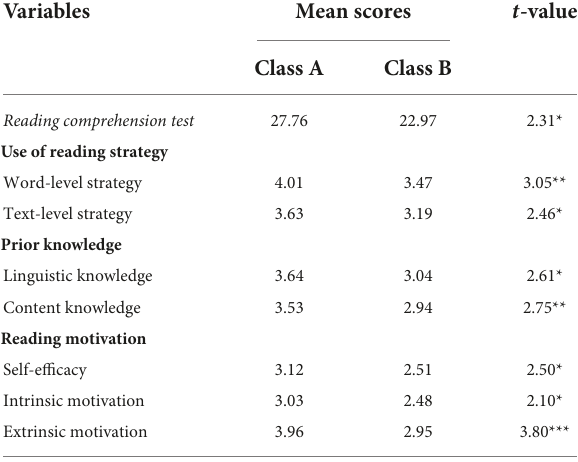
TABLE 2 Pre-test comparisons on the two experimental